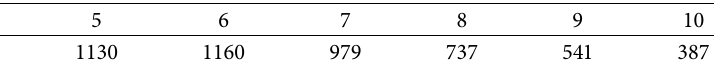
Figure 5: Spectral intensity of CO Table 1: Layer and temperature ( P � 1 atm; L �